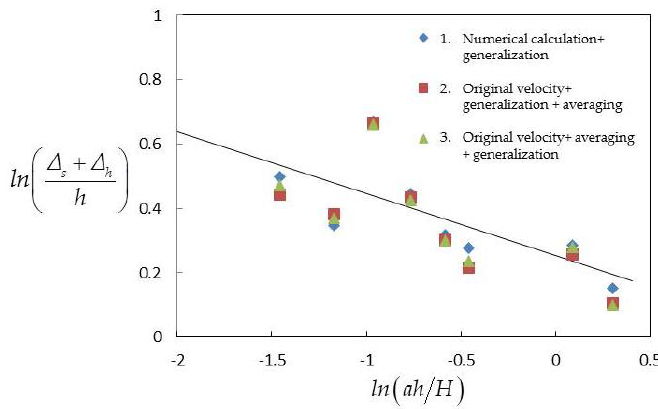
∆ s + h varies with the comprehensive parameter ah/H . (3 cases).